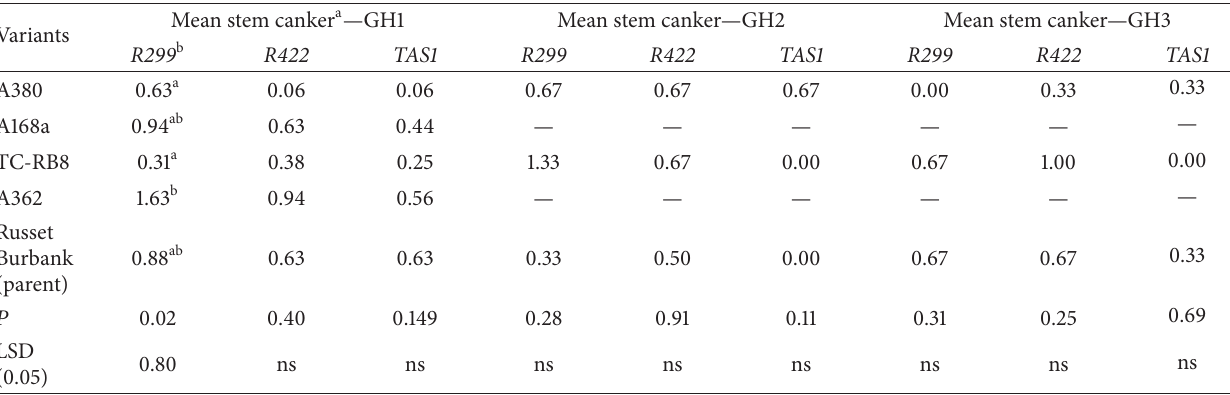
Table 5: Stem canker severity evaluation of selected potato cv. Russet Burbank variants in glasshouse (GH1—2010; GH2 and GH3—2011) trials. Rhizoctonia solani AG3 isolates R299, R422 , and TAS1 were tested separately in each trial.